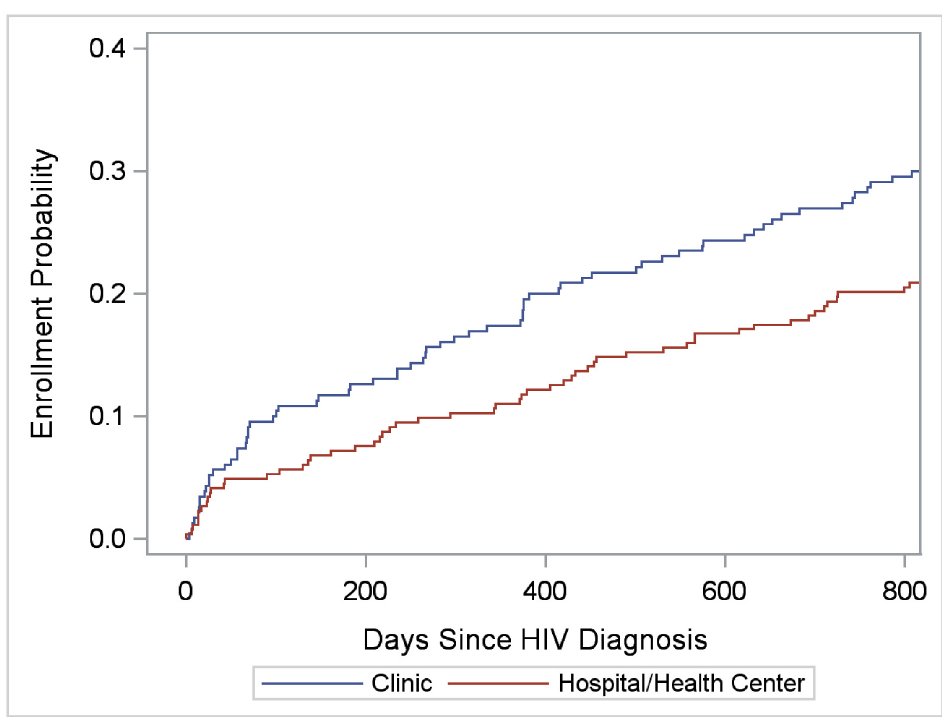
Fig 8. Cumulative verified enrollment in HIV care, by type of health facility, SHIMS female clients only. Log-rank test for differences in functions = 6.09; P = 0.014.